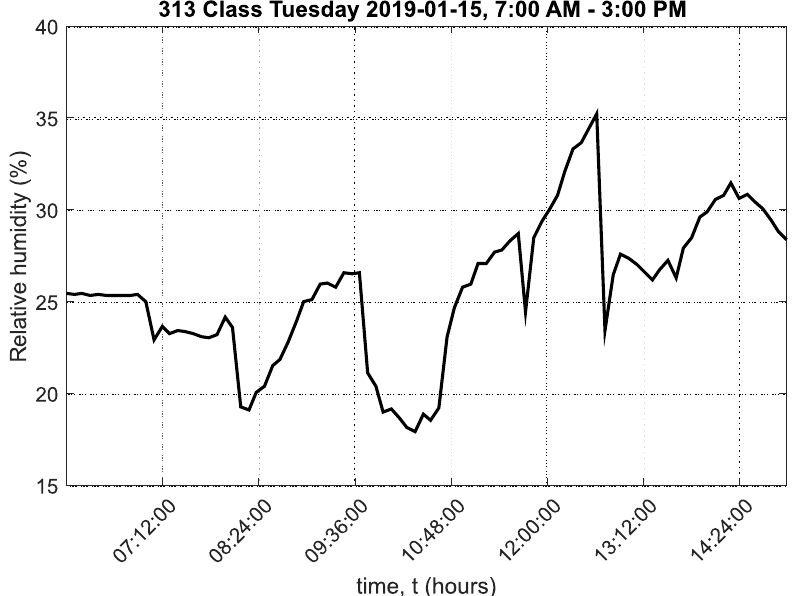
Figure A8. Graph of relative humidity of ambient air in classroom 313, Frenštát pod